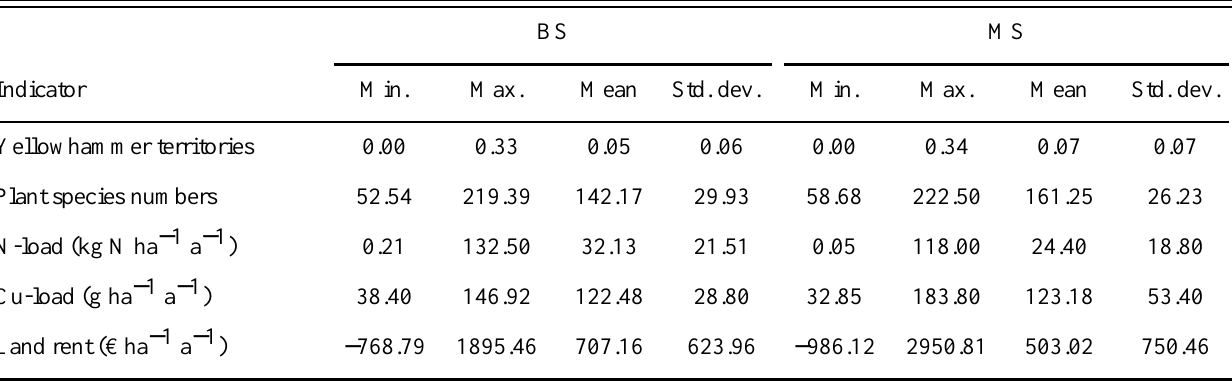
Table 4 . Indicator values in the BS and MS at the scale of spatial reference units. (See Table 1 for spatial reference units.)